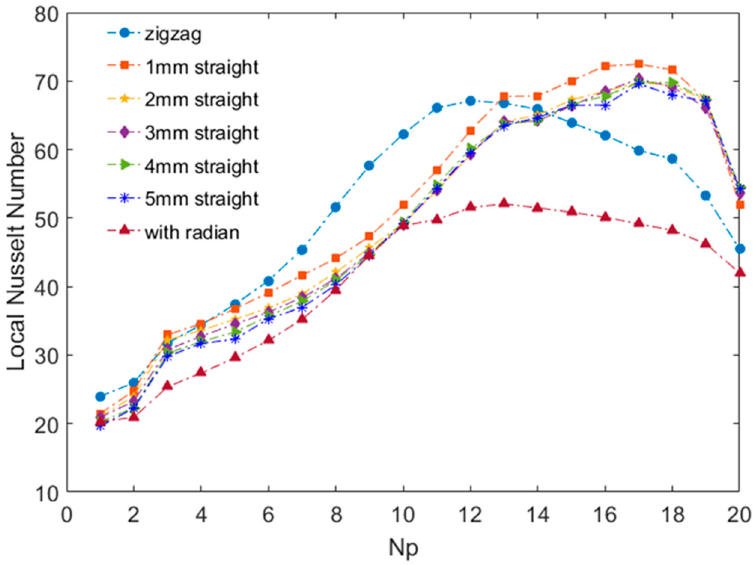
Figure 9. Nusselt number ( Nu ) along the flow direction for different channel shapes.